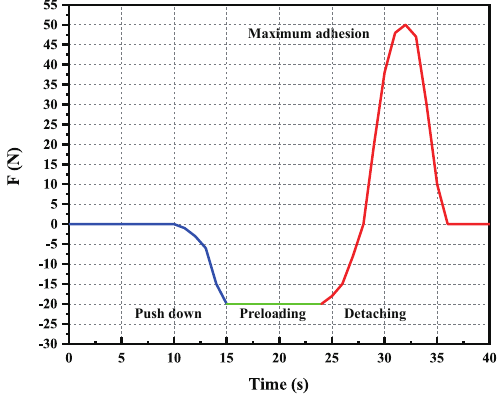
Figure 17. Experimental results of toe adhesion.